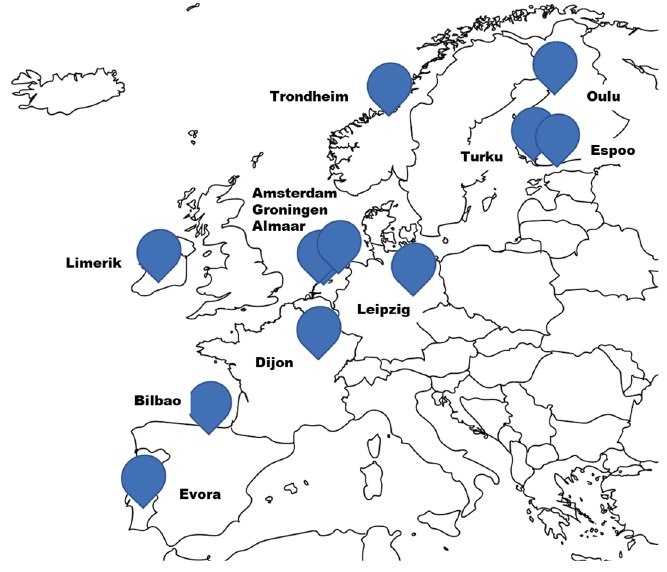
Figure 5. Geographical location of the analysed PEDs.